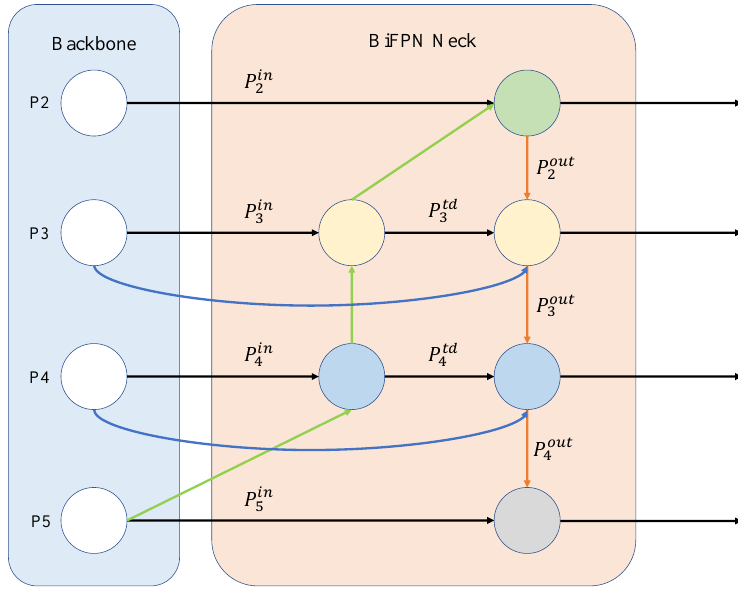
Figure 6. The conventional framework of the BiFPN.